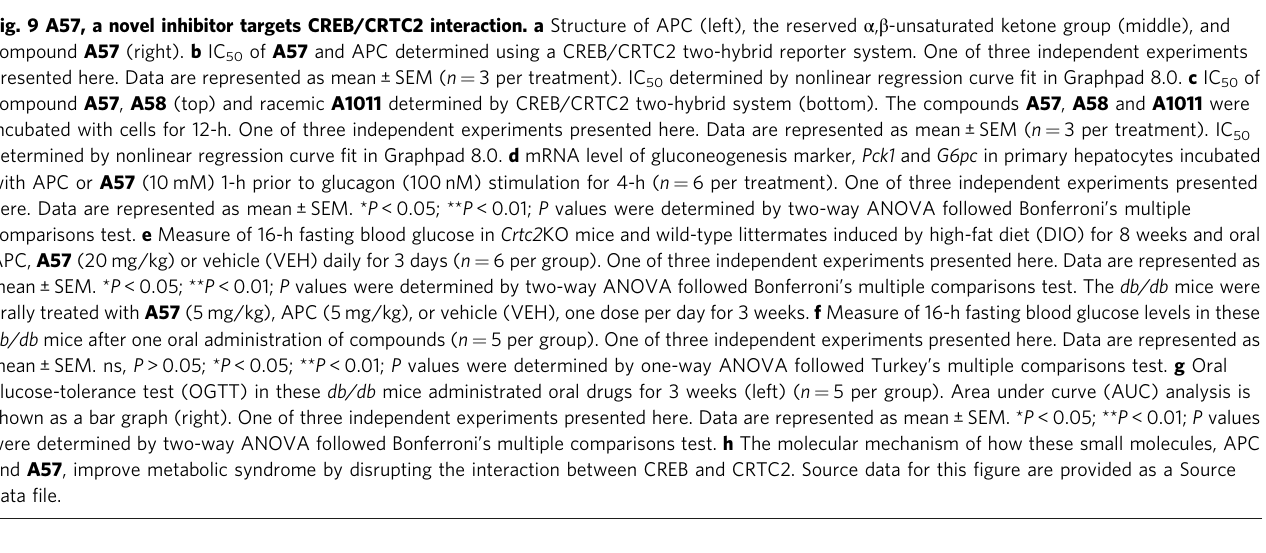
Fig. 9 A57, a novel inhibitor targets CREB/CRTC2 interaction. a Structure of APC (left), the reserved α , β -unsaturated ketone group (middle), and compound A57 (right). b IC 50 of A57 and APC determined using a CREB/CRTC2 two-hybrid reporter system. One of three independent experiments presented here. Data are represented as mean ± SEM ( n = 3 per treatment). IC 50 determined by nonlinear regression curve fi t in Graphpad 8.0. c IC 50 of compound A57 , A58 (top) and racemic A1011 determined by CREB/CRTC2 two-hybrid system (bottom). The compounds A57 , A58 and A1011 were incubated with cells for 12-h. One of three independent experiments presented here. Data are represented as mean ± SEM ( n = 3 per treatment). IC 50 determined by nonlinear regression curve fi t in Graphpad 8.0. d mRNA level of gluconeogenesis marker, Pck1 and G6pc in primary hepatocytes incubated